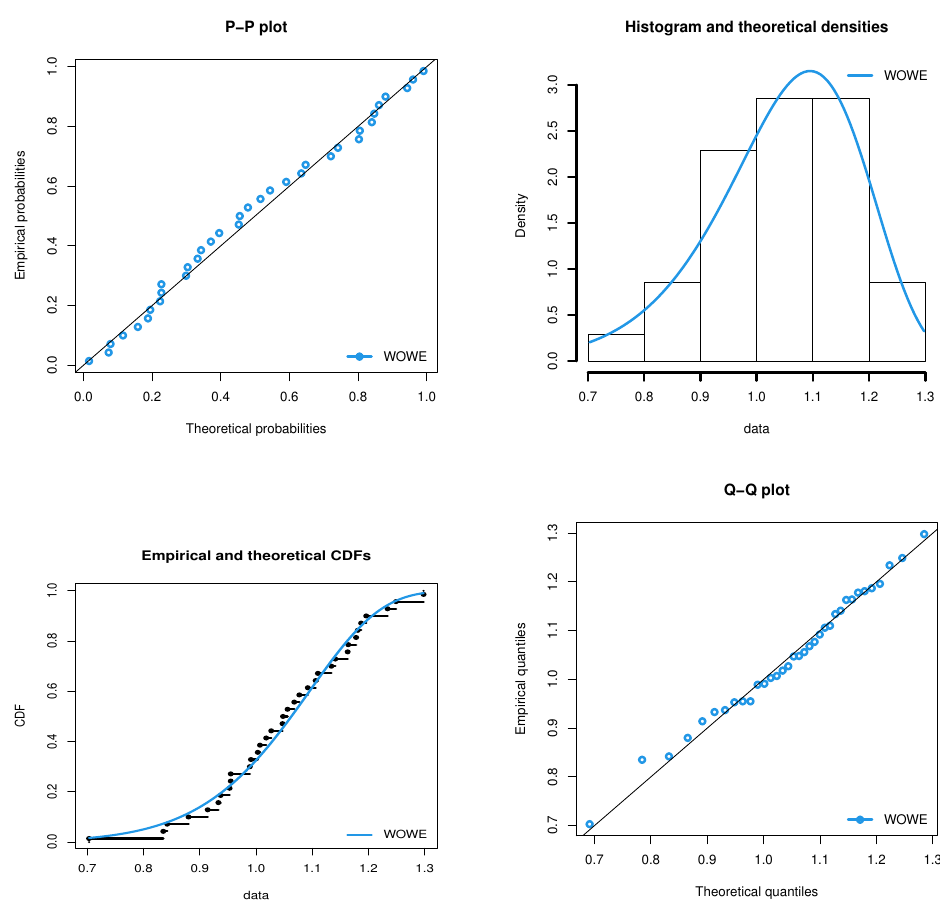
Figure 4. Plots of four estimated objects for the daily precipitation data.